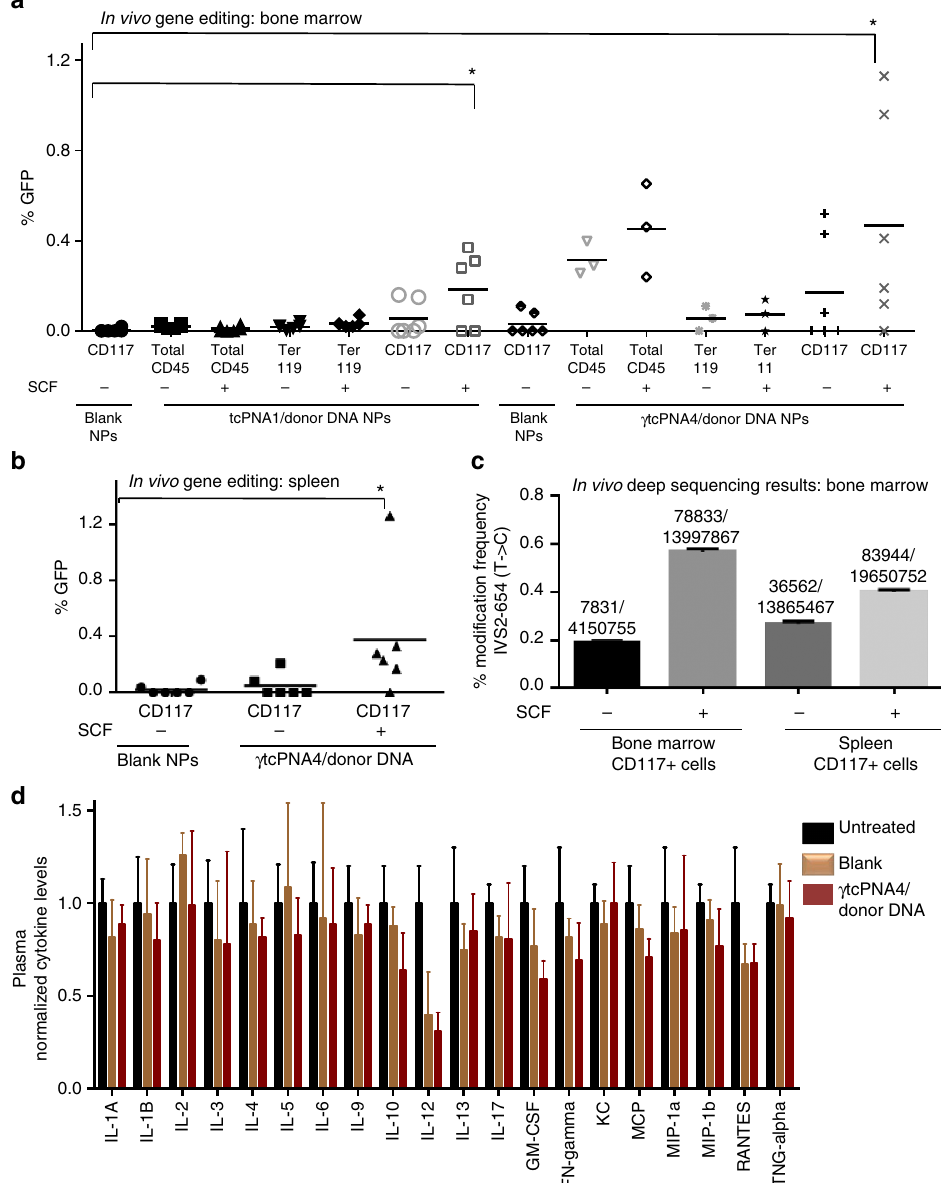
Figure 3 | SCF treatment of mice enhances in vivo gene editing by c tcPNAs and donor DNAs. ( a , b ) b -globin/GFP transgenic mice ( n ¼ 6 mice per group) were injected or not (as indicated) with 220 m gkg (cid:2) 1 of SCF i.p. followed by a single treatment of 4mg of NPs injected intravenously. Each group received either blank NPs, NPs containing tcPNA1 and donor DNA, or NPs containing g tcPNA4 and donor DNA, with or without SCF. Two days later, BM and spleen cells were harvested for analysis by flow cytometry and deep sequencing. Frequencies of gene editing in haematopoietic cell sub-populations identified by the indicated cell surface markers from BM ( a ) and spleen ( b ) of mice treated with the indicated NPs and with or without pre-treatment with SCF. Each data point represents analysis of cells from a single mouse. Horizontal bars indicate mean, statistical analysis by Student’s unpaired t -test, * P o 0.05. ( c ) Deep-sequencing analysis to quantify the frequency of targeted gene editing in vivo in CD117 þ cells from BM and spleen of b -globin/GFP mice treated as above. Error bars indicate standard error of proportions. ( d ) Analysis of cytokine levels, as indicated, in blood of either untreated, blank NP treated, or g tcPNA4 and donor DNA NP treated mice at 48h post treatment. Data are shown as mean ± s.e.m., n ¼